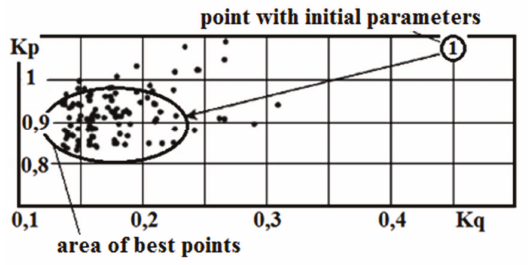
Fig. 2. Fragment of a distribution of sampling points on the criteria plane (Kp; Kq) The compromise curve features three points, which are located on the by-passing curve A (Fig. 3) limited with lines D and E. The numbers of those points are – 61, 121, 106, and the part of the curve joining these points is the compromise confidence curve. Points № 48 and № 127 are also located on curve A, but curve A is not a compromise curve to the right of point № 106. Indeed, on a part of curve A separated with a dotted line there are points for which two criteria vary either up to the maximum or to the mini- mum side. For instance, for the minimum value of criterion Kq = 0.2, a point of intersection of curve A with the indi- cated weight of Kq should be found to obtain the best quali- ty.